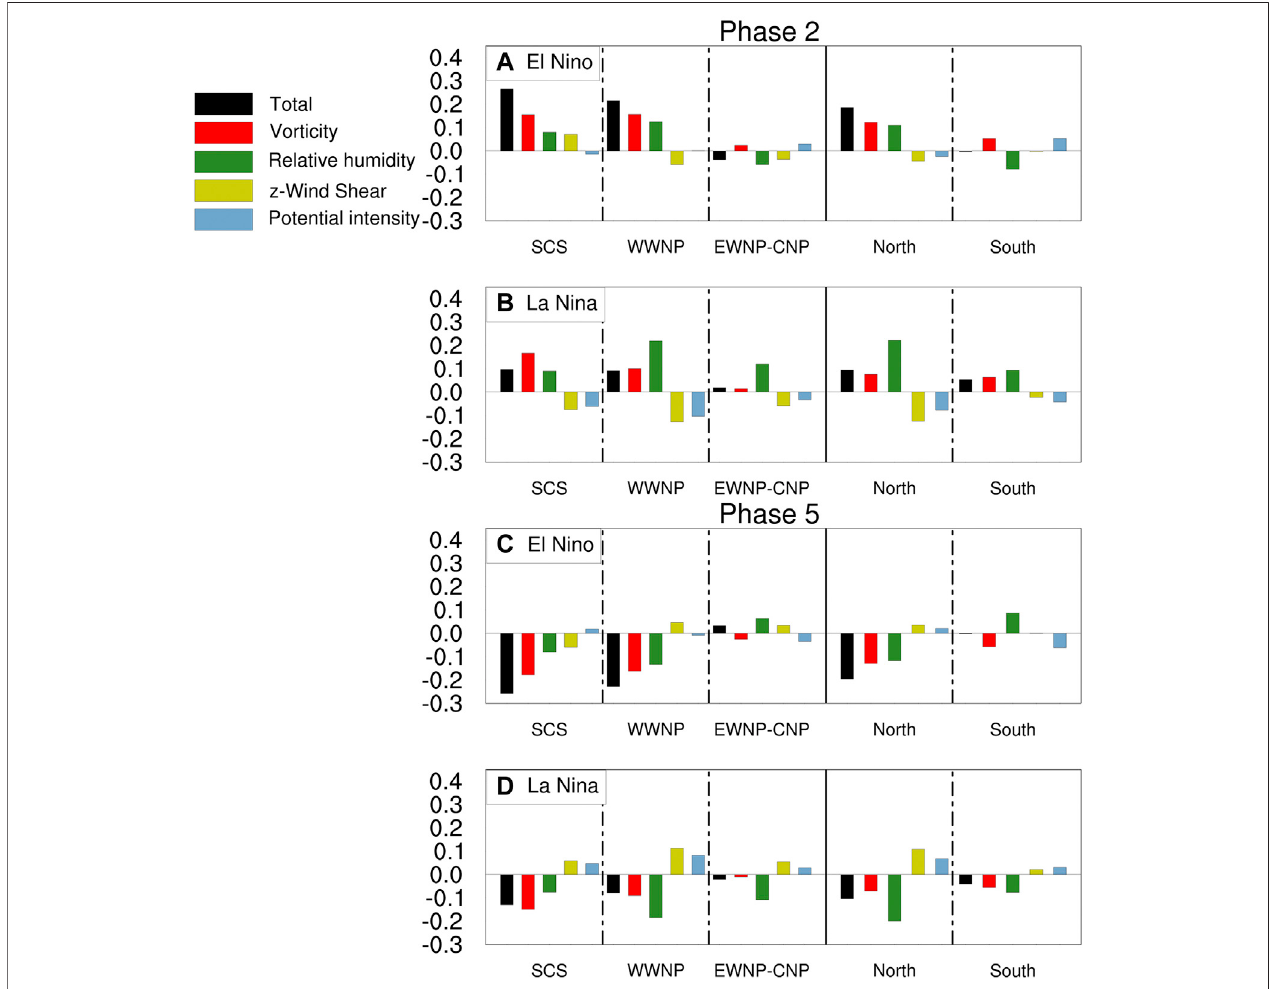
FIGURE 11 | CompositebudgettermsofthetotalGPI anomaliesbased onphasesofEAP-ISVover threeseaareas and meridional partition in ElNiñoandLa Niñayears.